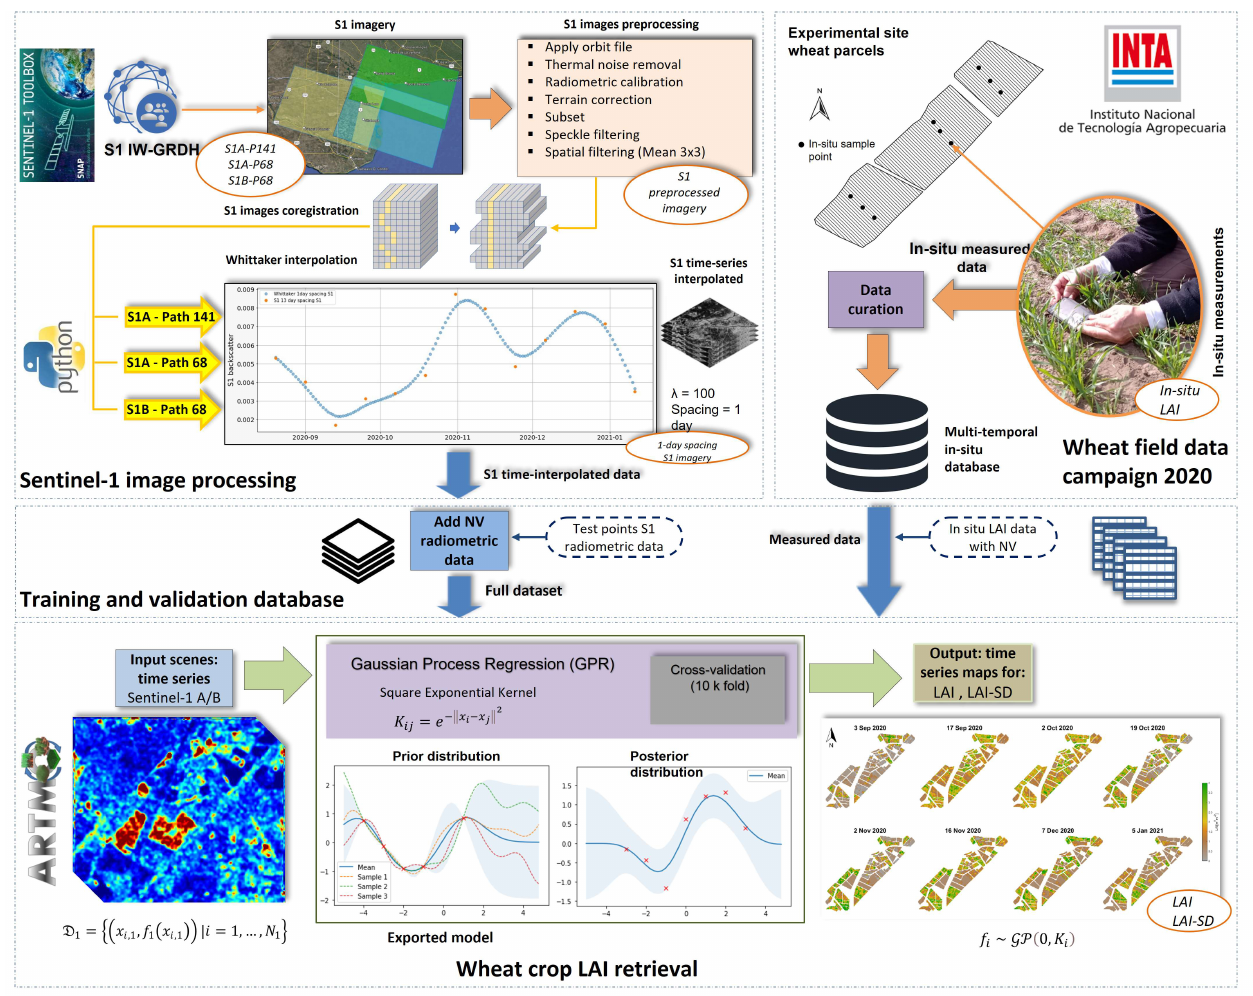
Figure 4. Retrieval workflow for the GPR-S1-LAI modeling using multiple local incidence angles of S1 polarimetric data, partly adapted from [63]. The output maps show our S1-derived LAI maps over the BVCR study